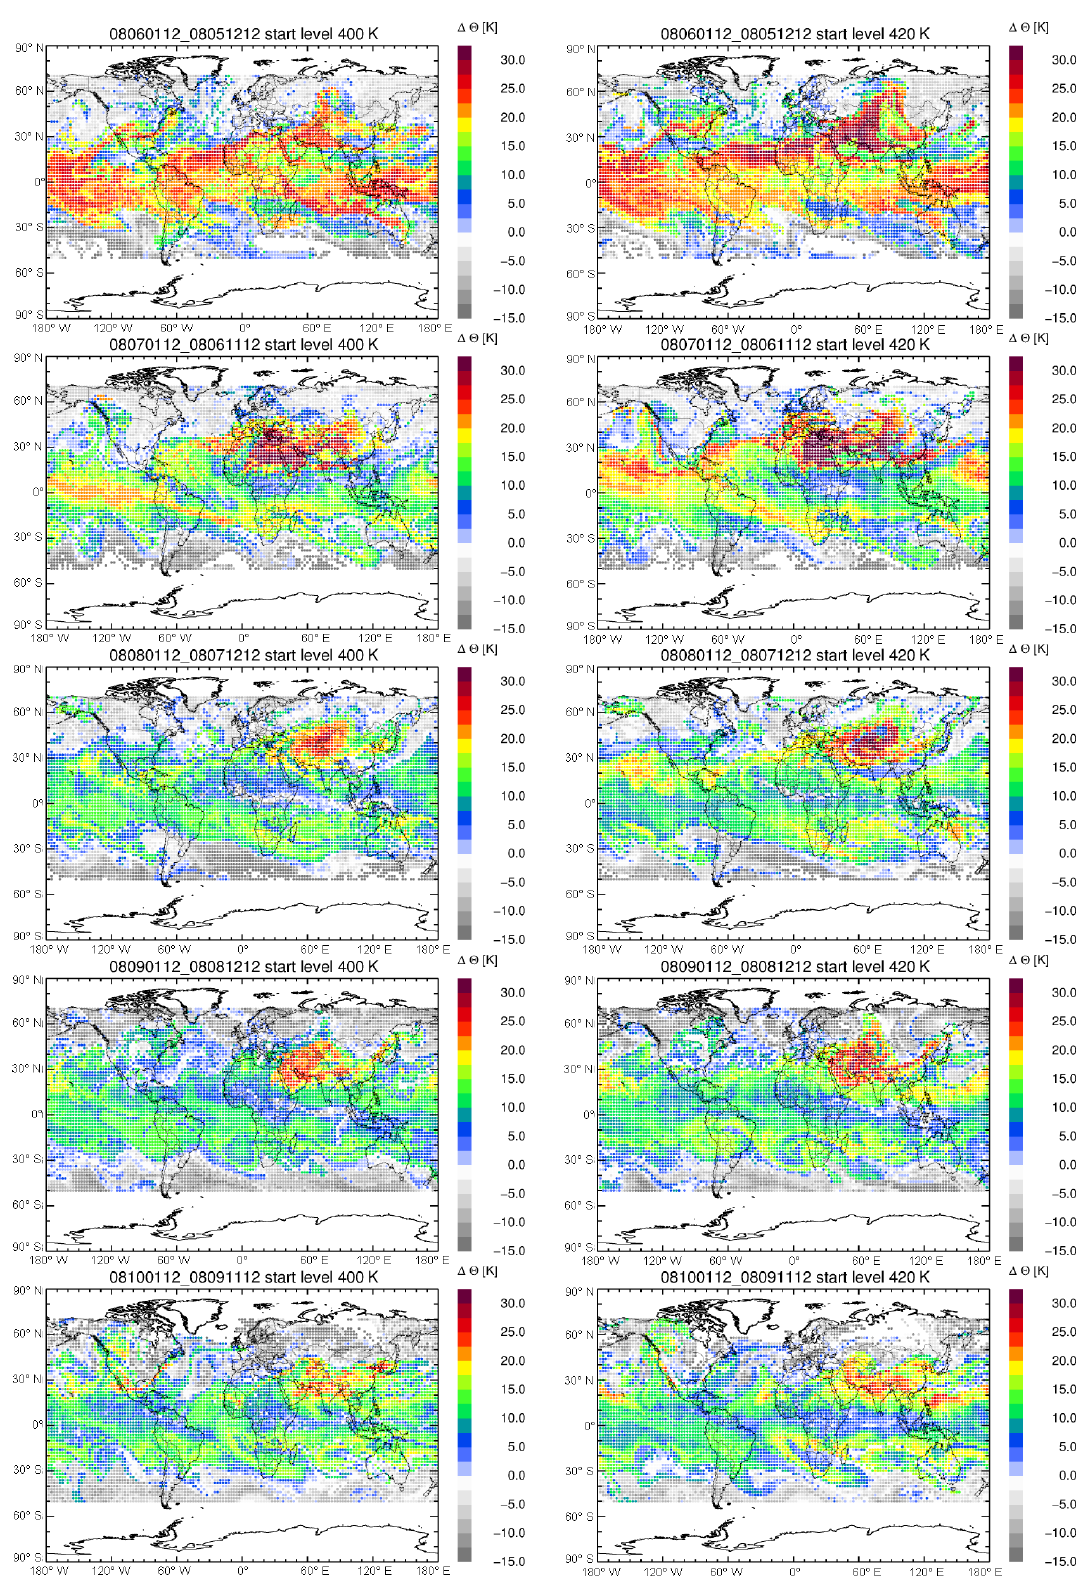
Figure A1. The change in potential temperature ( (cid:49)(cid:50) ) along 20-day backward trajectories are shown for different levels of potential tempera- ture (400 and 420K) for different days from monsoon onset until post-monsoon (1 June, 1 July, 1 August, 1 September, and 1 October